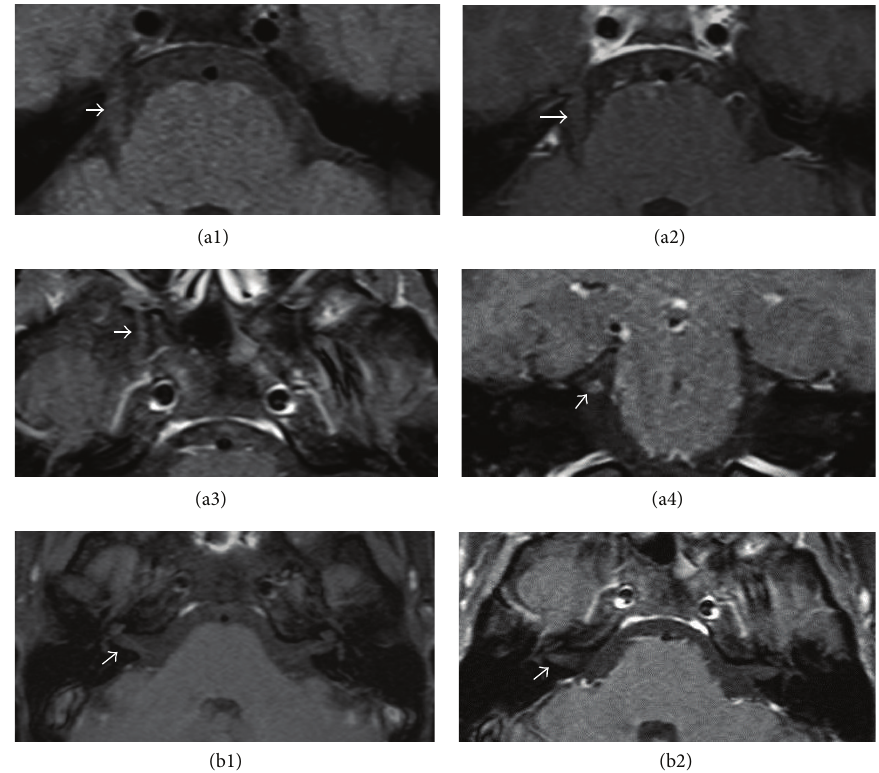
Figure 2: Axial MRI sections of the brainstem at the pontine level demonstrated fusiform enlargement of the fifth cranial nerve at the cisterna level on the T1-weighted images (a1). Postcontrast, fat-suppressed T1 images showed slight enhancement that is disclosed on cisterna level of the fifth cranial nerve (a2) and enlargement of the maxillary division of the fifth cranial nerve with slight enhancement while it passed foramen rotundum (a3). Also coronal MRI section at the level of the fifth cranial nerve showed slight enhancement (a4). Axial MRI sections showed brain stem at the level of facial and vestibulocochlear nerves in precontrast image (b1) and slight enhancement in postcontrast study